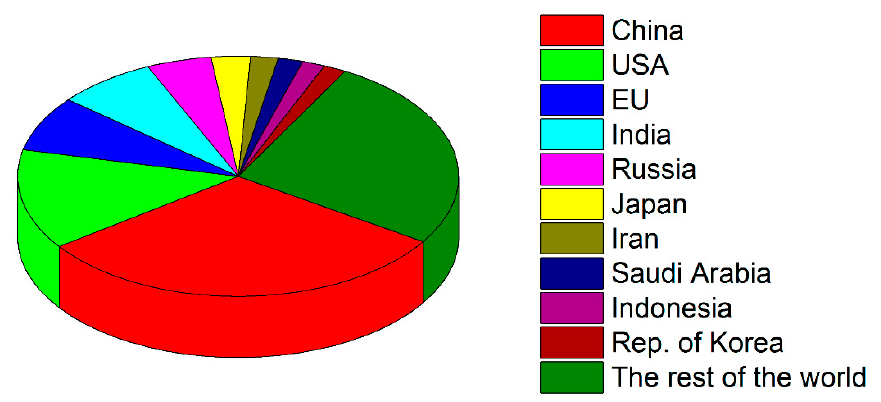
Figure 2. The proportion of different countries/political blocks in CO 2 emissions in 2021, in descend- ing order. The total amount was estimated as 37.124 billion tons of CO 2 [25].